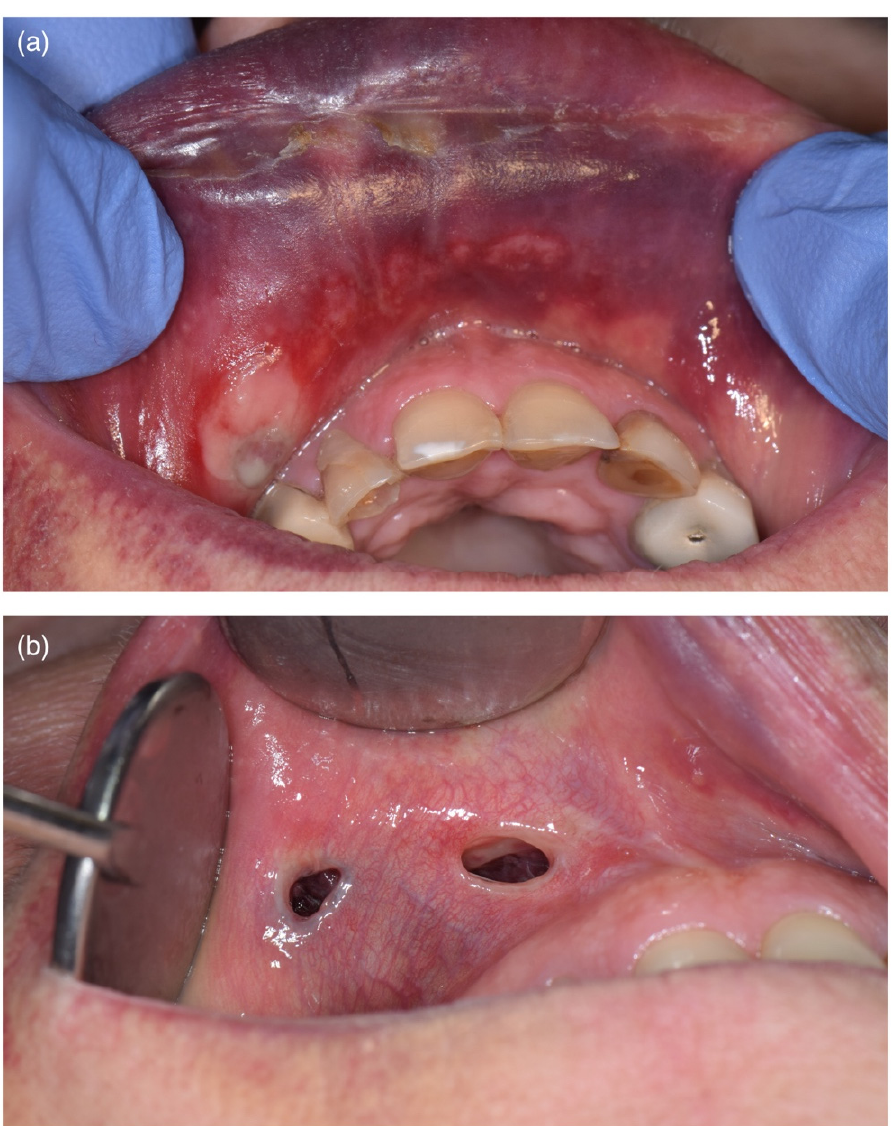
Figure 2. First case: intraoral clinical manifestations. ( a ) Day 1: ulcerative lesions on the internal mucosa of the lip. ( b ) Day 3: chemical burns became ulcers.